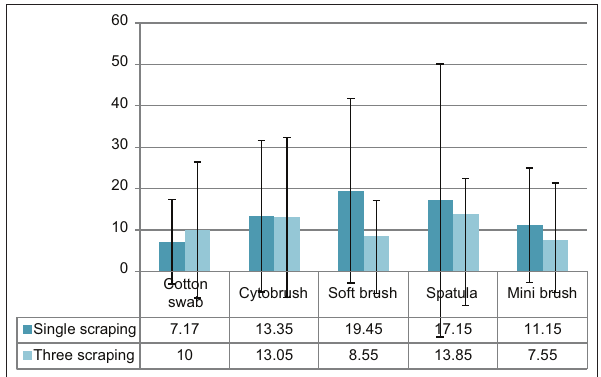
Figure-2: Cell average count with a standard Table-2: Animal discomfort 1–3 (1=eyes opened, 2=eyes partially opened, 3=or eyes squinted) [14]. Cytology method